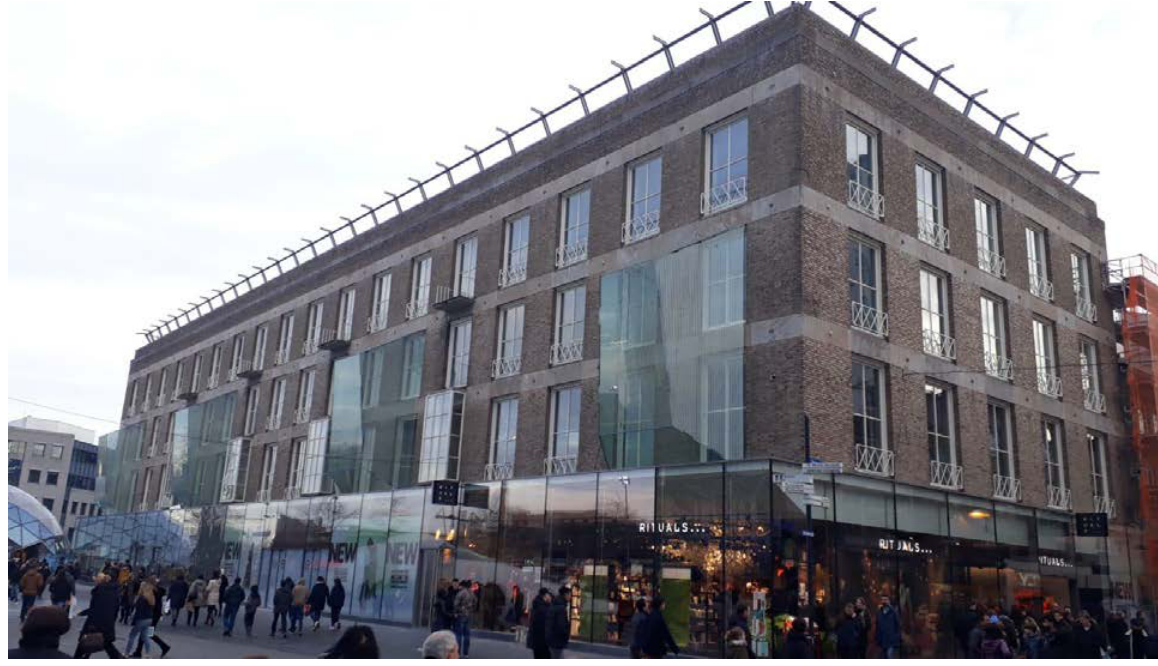
Fig. 19 photo of four transparent floating boxes in January